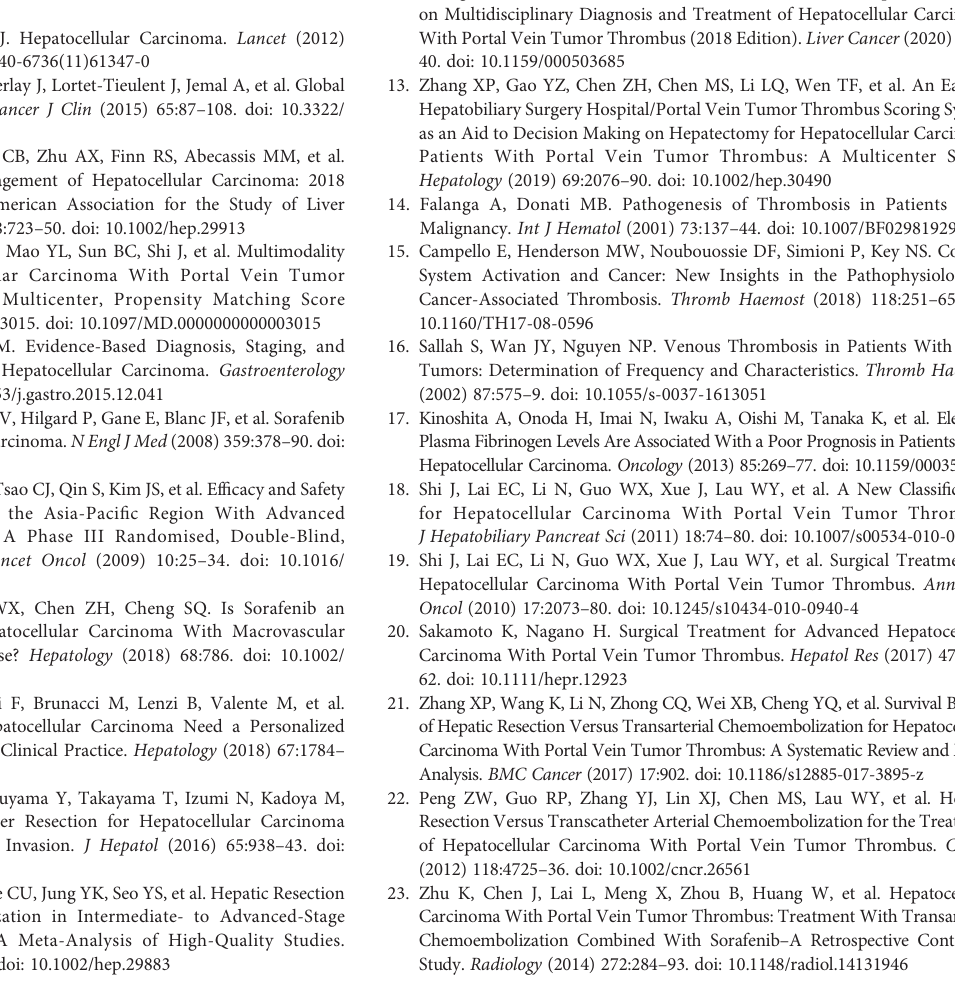
Supplementary Figure 1 | Kaplan-Meier analysis for subgroup analysis of the RFS and OS rates in HCC patients with types I/II PVTT after R0 LR among the Low, Normal, and High INR groups. RFS for patients with type I PVTT among the Low, Normal, and High INR groups (55 patients vs 113 patients vs 37 patients) after R0 LR (A) (P < 0.001); OS for patients with type I PVTT among the Low, Normal, and High INR groups (55 patients vs 113 patients vs 37 patients) after R0 LR (B) (P < 0.001); RFS for patients with type II PVTT among the Low, Normal, and High INR groups (89 patients vs 229 patients vs 69 patients) after R0 LR (C) (P = 0.019); OS for patients with type II PVTT among the Low, Normal, and High INR group (89 patients vs 229 patients vs 69 patients) after R0 LR (D) (P < 0.001). INR, international normalized